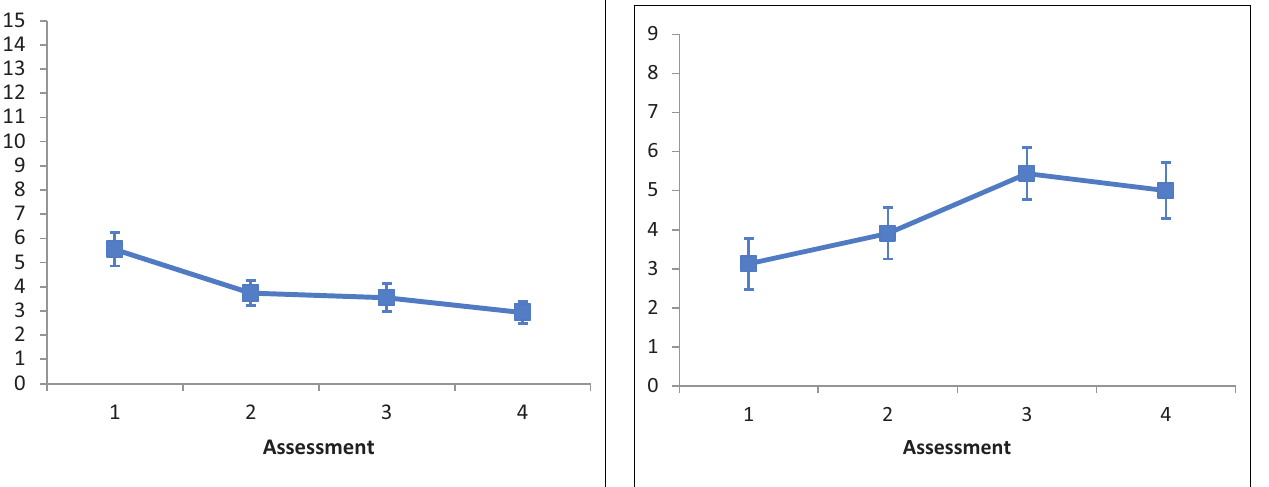
FIGURE 1 | LN patients’ performance on the Fluff test as a function of assessment . Error bars represent 1 SEM.